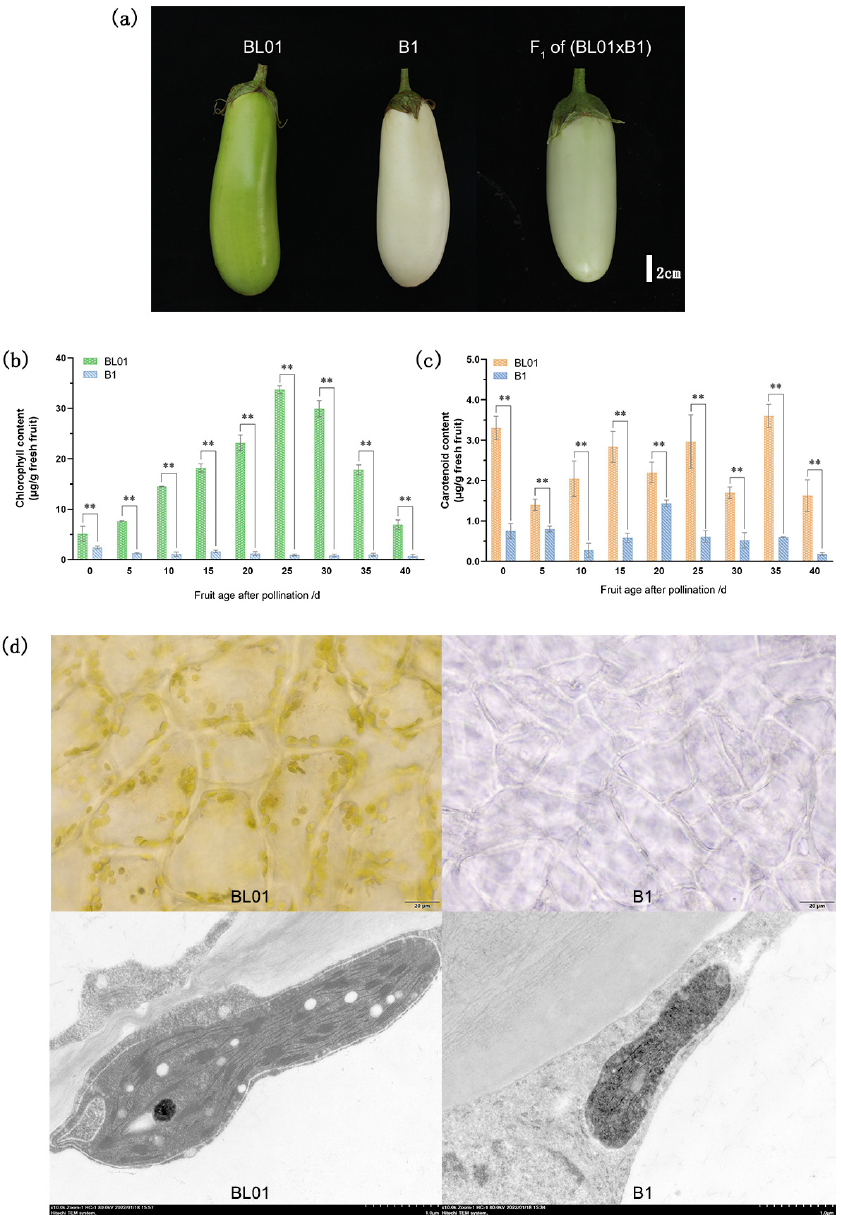
Figure 1. Phenotypic characteristics, pigment content, and cytological observations of the parental lines peel. ( a ) Peel characteristics of BL01 and B1, and their F 1 progeny, Bar = 2 cm; ( b ) chlorophyll content and ( c ) carotenoid content of the parental lines peel; ( d ) cytological observations of the parents, from left to right, are BL01, and B1, from top to bottom, are fluorescence microscopy and transmission electron microscopy. **, p < 0.01.